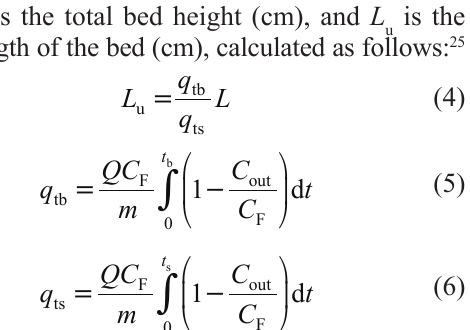
Table 2 – Operating conditions of column adsorption experi- ments Q (L min –1